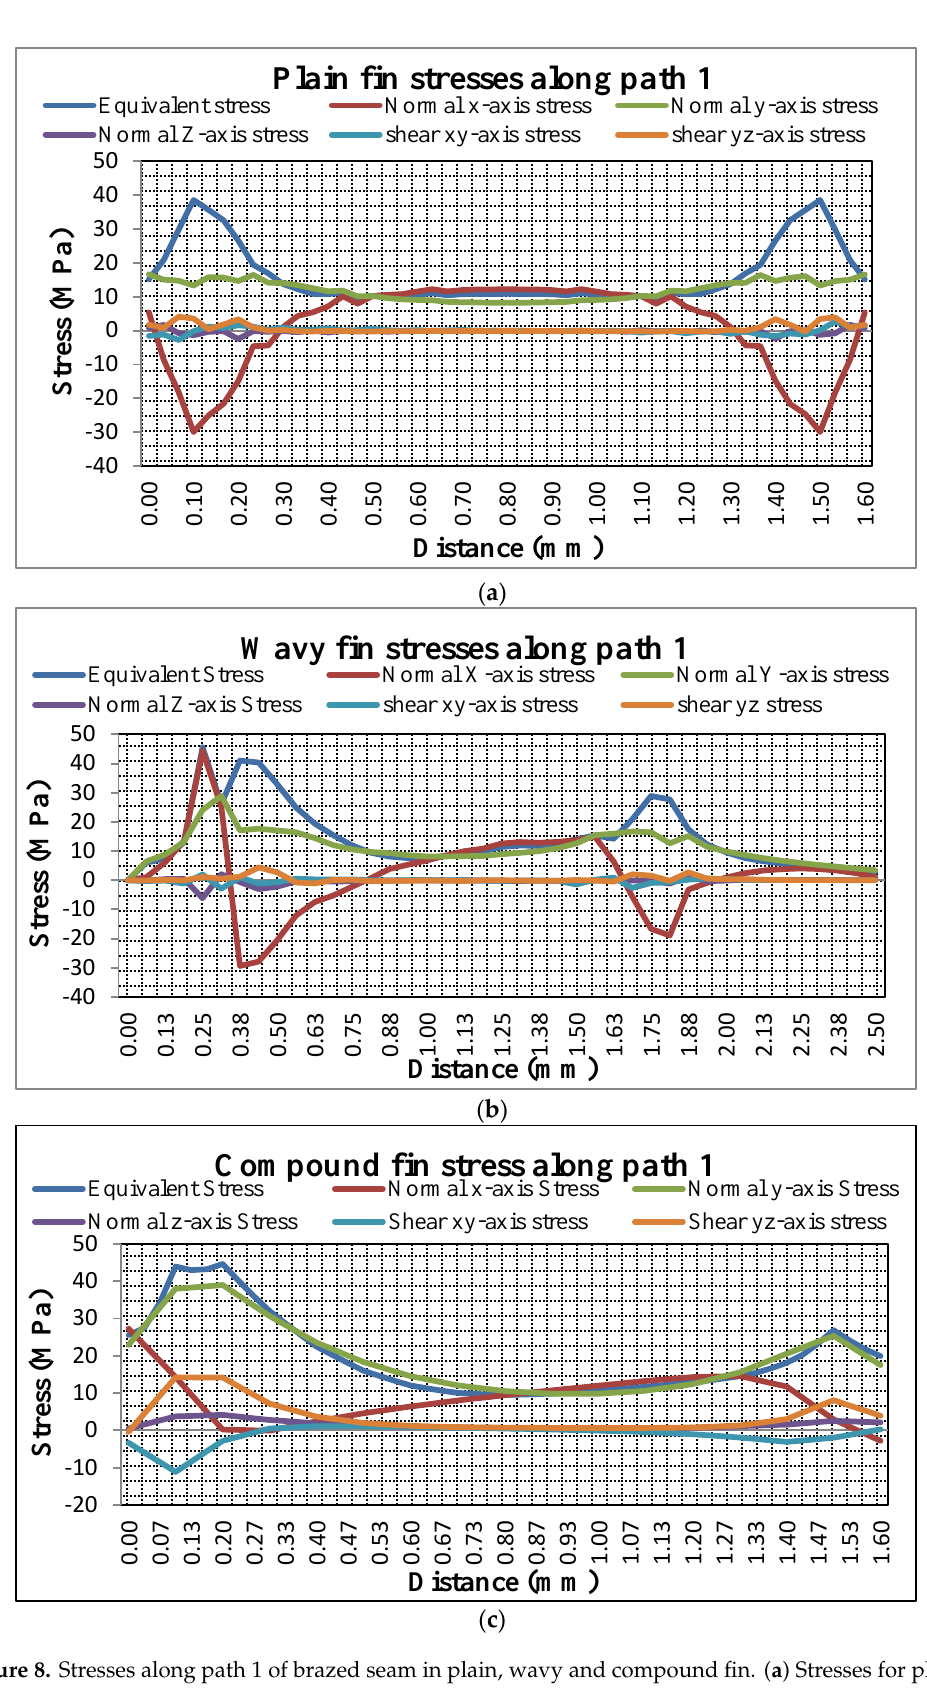
Figure 8. Stresses along path 1 of brazed seam in plain, wavy and compound fin. ( a ) Stresses for plain fin. ( b ) Stresses for wavy fin ( c ) Stresses for compound fin.